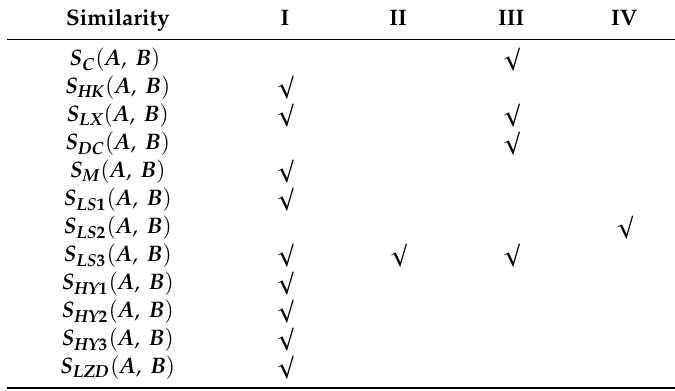
Table 1. The four types of components of distance-based similarity measures.